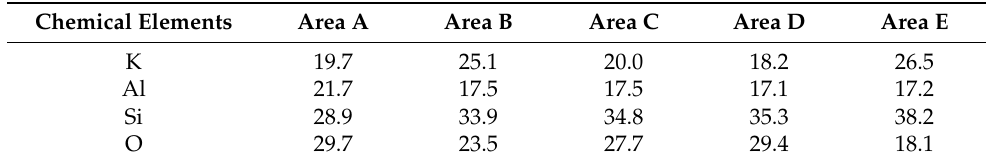
Table 1. TEM-EDS results of atom fraction of chemical composition of the glass phase in calcined K geopolymer.